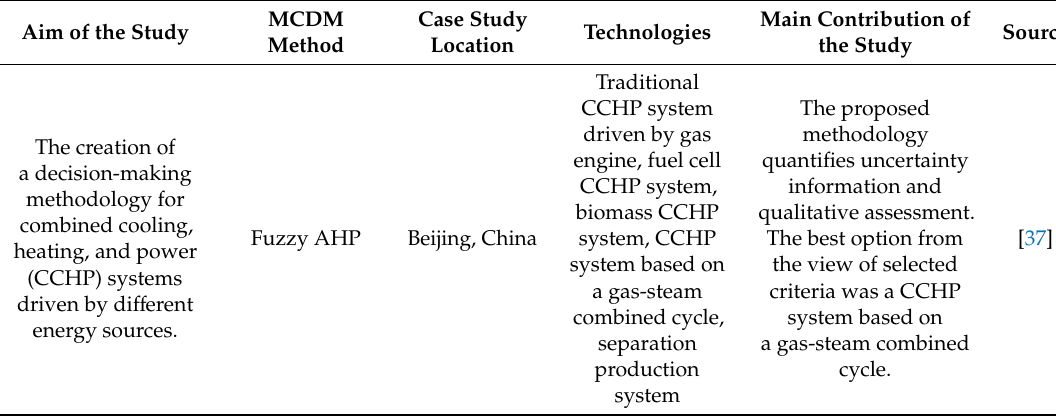
Table 3. Evaluation of hybrid energy systems